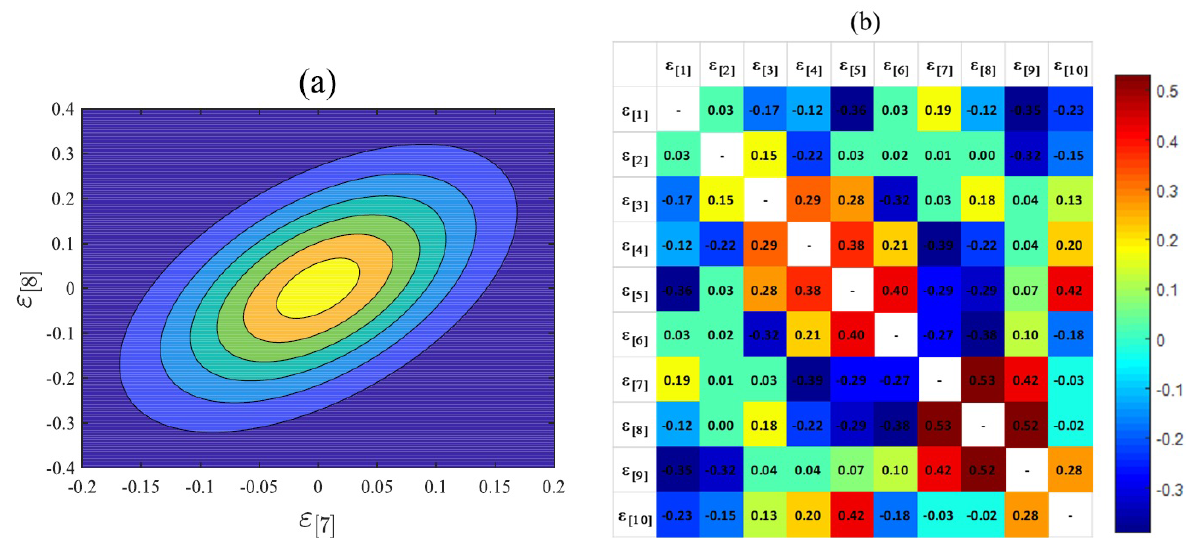
Figure 7. (a) Comparison of estimator d c( 1 ) (horizontal axis) with estimator b V 2 rainfall. (b) The histogram of the discrepancies between these two estimators at gauge NCDC-200164.